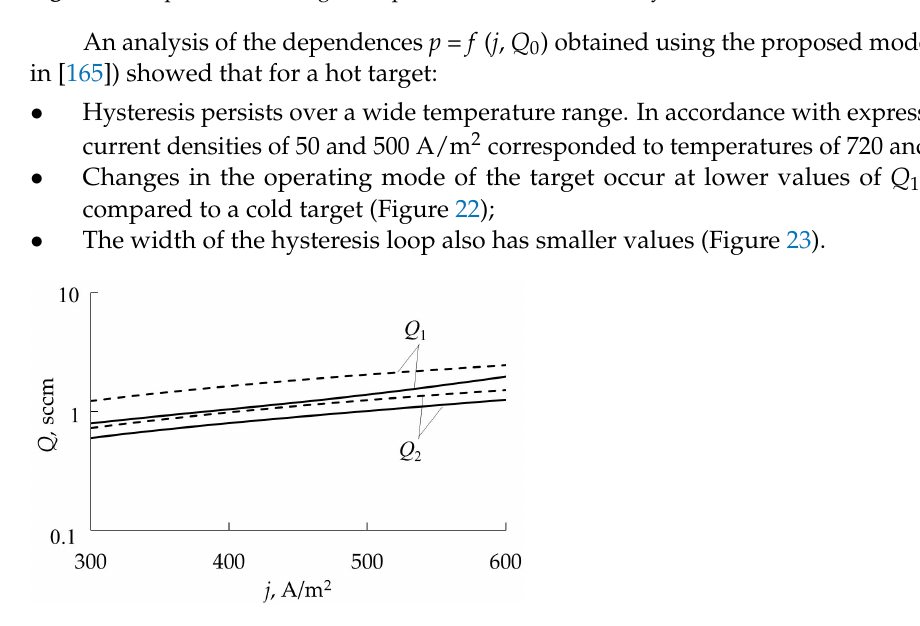
Figure 21. Dependence of target temperature on current density.